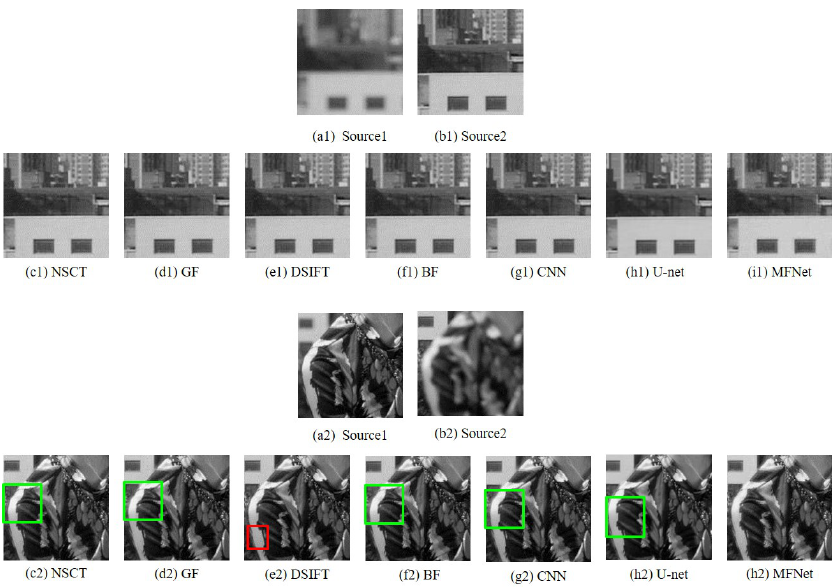
Figure 8. Magnified regions of the “Model Girl” source images and fused images obtained with different